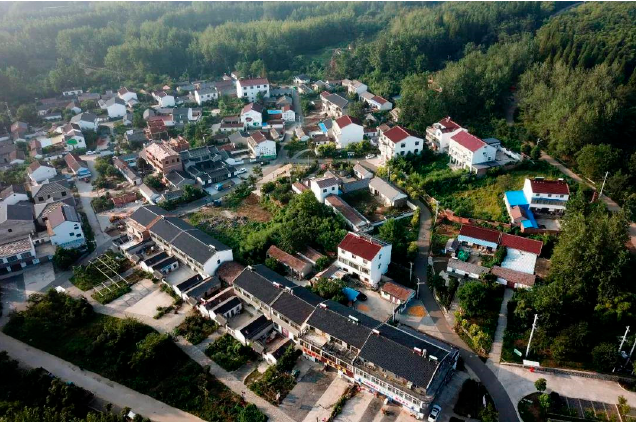
Figure 6. The picture of Doushan Village.